Question: Based on the figure, does the quantity rise or fall?
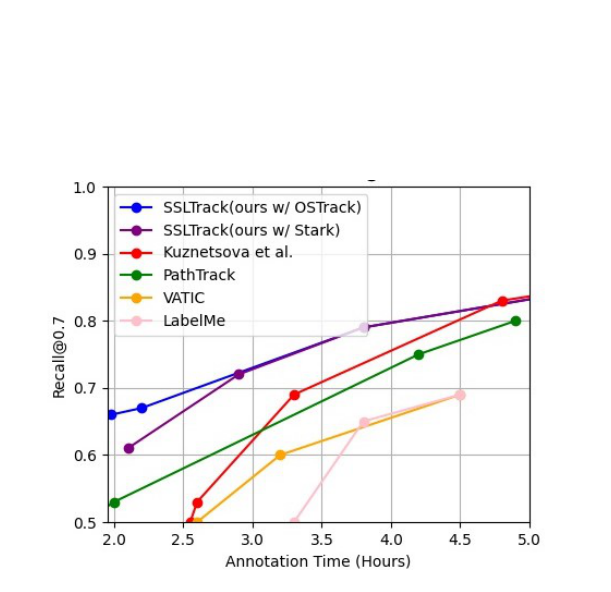
Answer: increasing